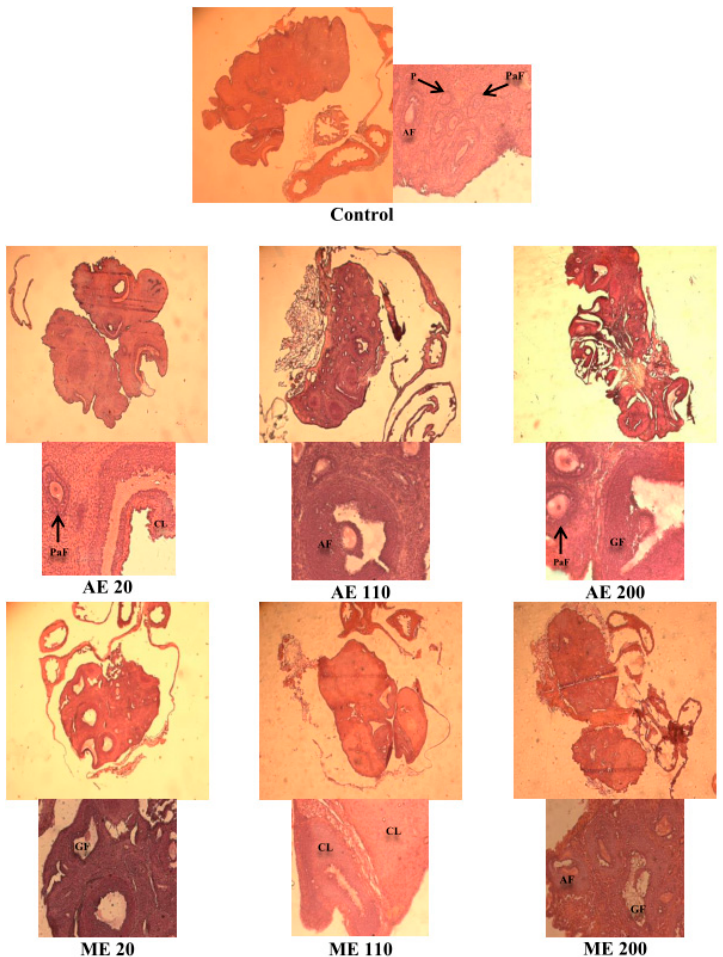
Figure 4. Microphotographs (25× and 200×) of hematoxylin/eosin stained sections of ovaries following a 30-day treatment with aqueous (AE) and methanol (ME) extracts of the leaves of M. arboreus at the doses of 20, 110 and 200 mg/kg. P = primary follicle, PF = primordial follicle, PaF = preantral follicle, AF = antral follicle, GF = Graafian follicle, CL = corpora lutea.